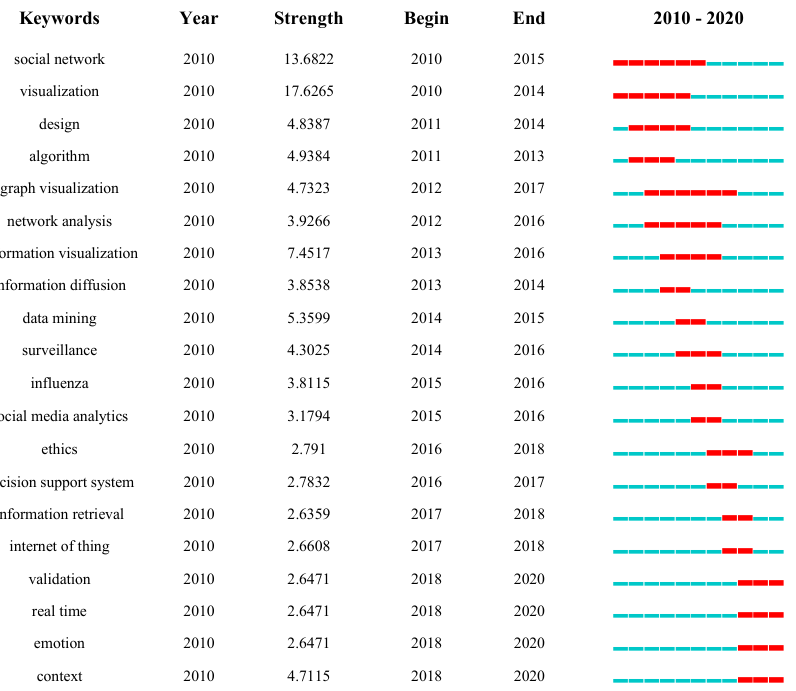
Figure 8. Keywords with the strongest citation burst in SMBD.